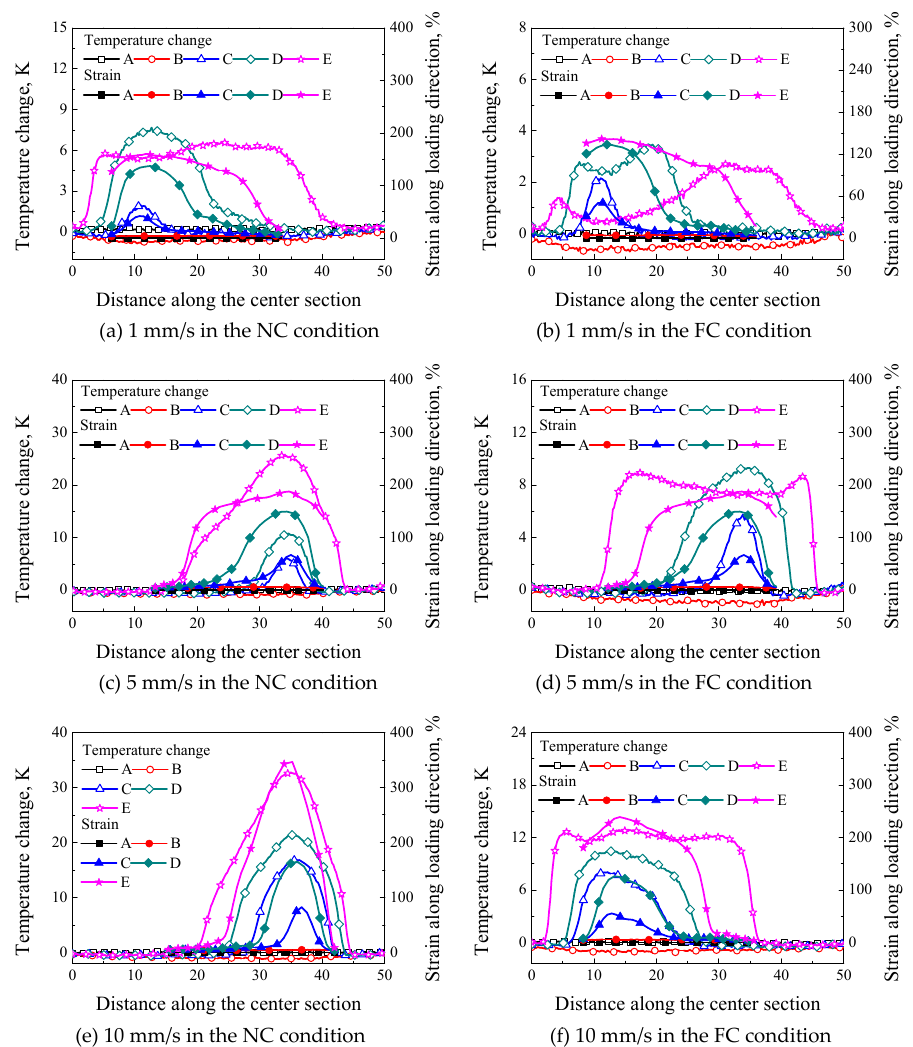
Figure 11. The correlation between the temperature change and strain at di ff erent loading rates and convection conditions: ( a ) 1 mm / s in the NC condition; ( b ) 1 mm / s in the FC condition; ( c ) 5 mm / s in the NC condition; ( d ) 5 mm / s in the FC condition; ( e ) 10 mm / s in the NC condition and ( f ) 10 mm / s in the FC